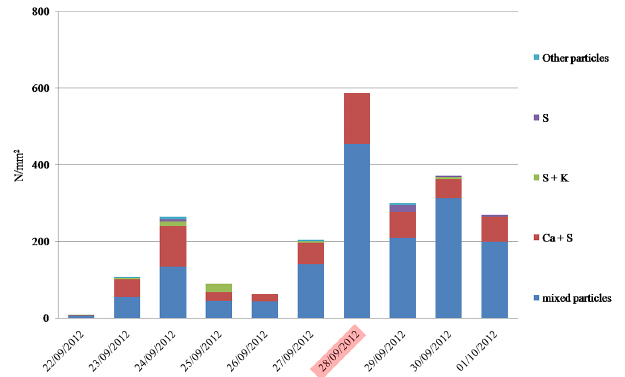
Figure 6. Numerical relative amounts (%) of the phases com- posing the mineral component in the ≥ 0.7 µm fraction. Alu- minosilicates consisted primarily of clay minerals, with smec- tite (cid:29) kaolinite>illite/mica. The flare event date is highlighted in red.